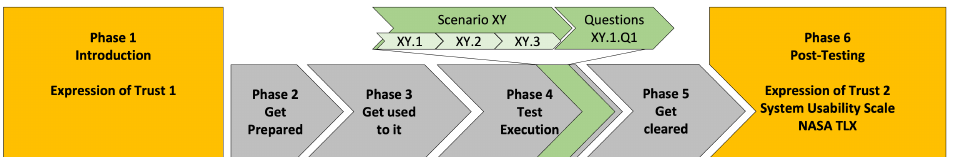
Figure 3. Experiment procedure for each individual participant. (XY represents the number of the scenario, XY.1 the first scene within the scenario XY, and XY.1.Q1 represents question one targeting the specific scene within the scenario